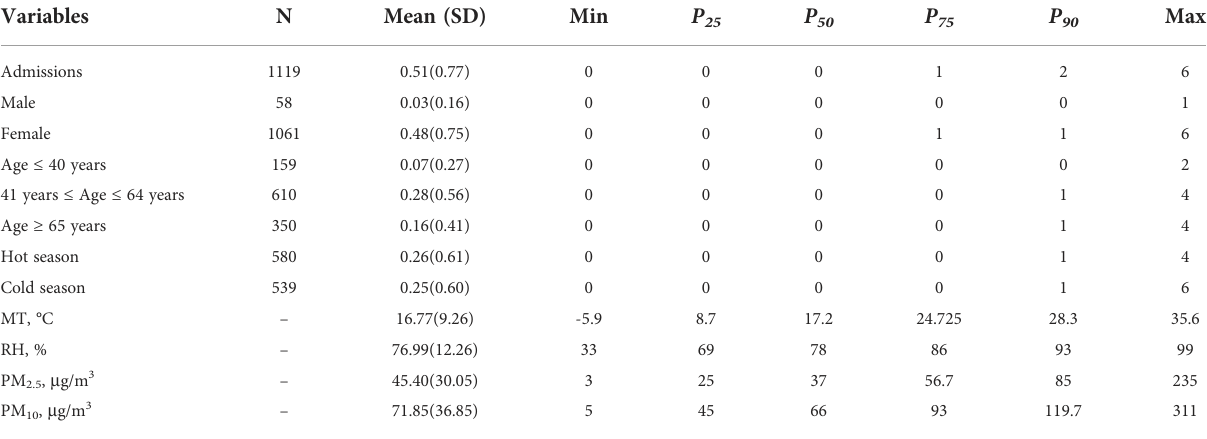
TABLE 1 The basic information of SS hospitalizations, meteorological data and particulate